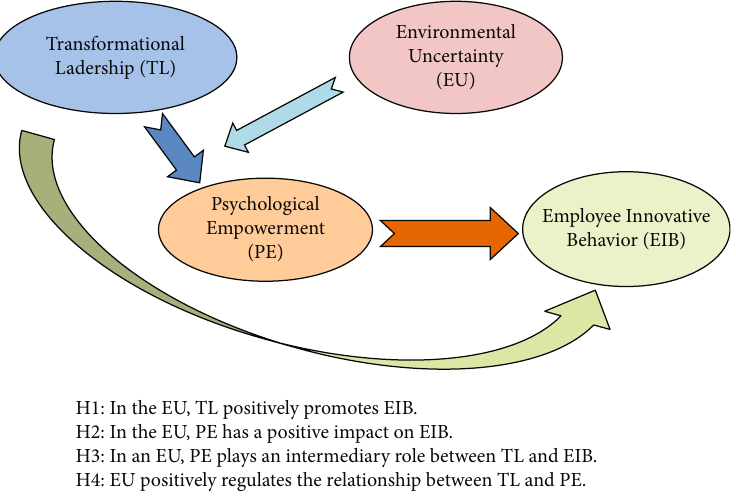
Figure 1: Research